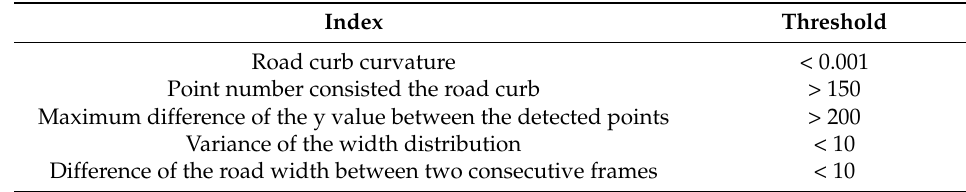
Table 2. Threshold for each index.